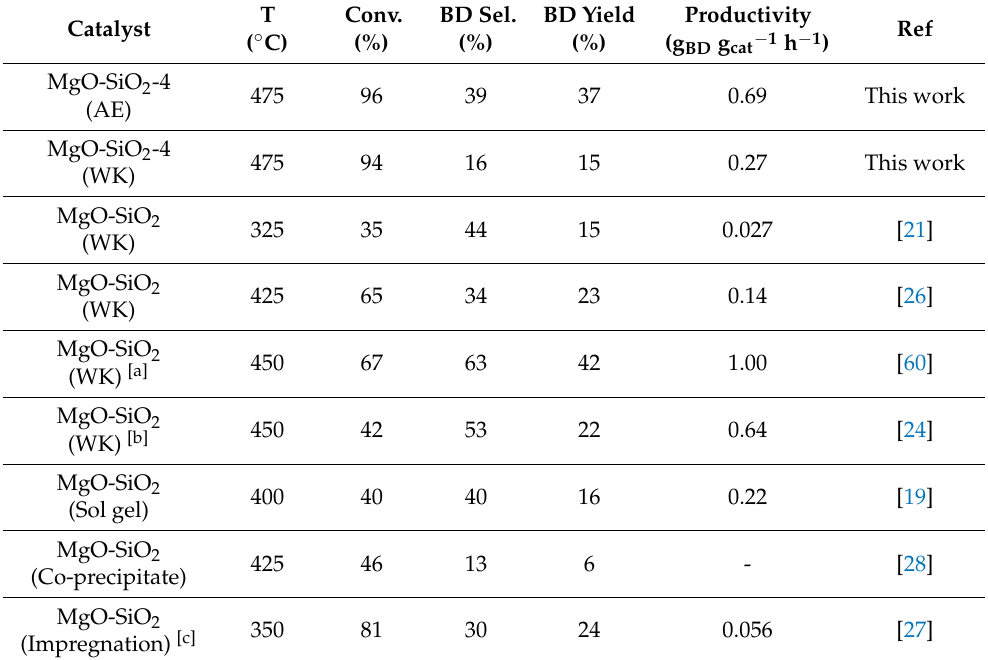
Table 2. Catalytic performance of MgO-SiO 2